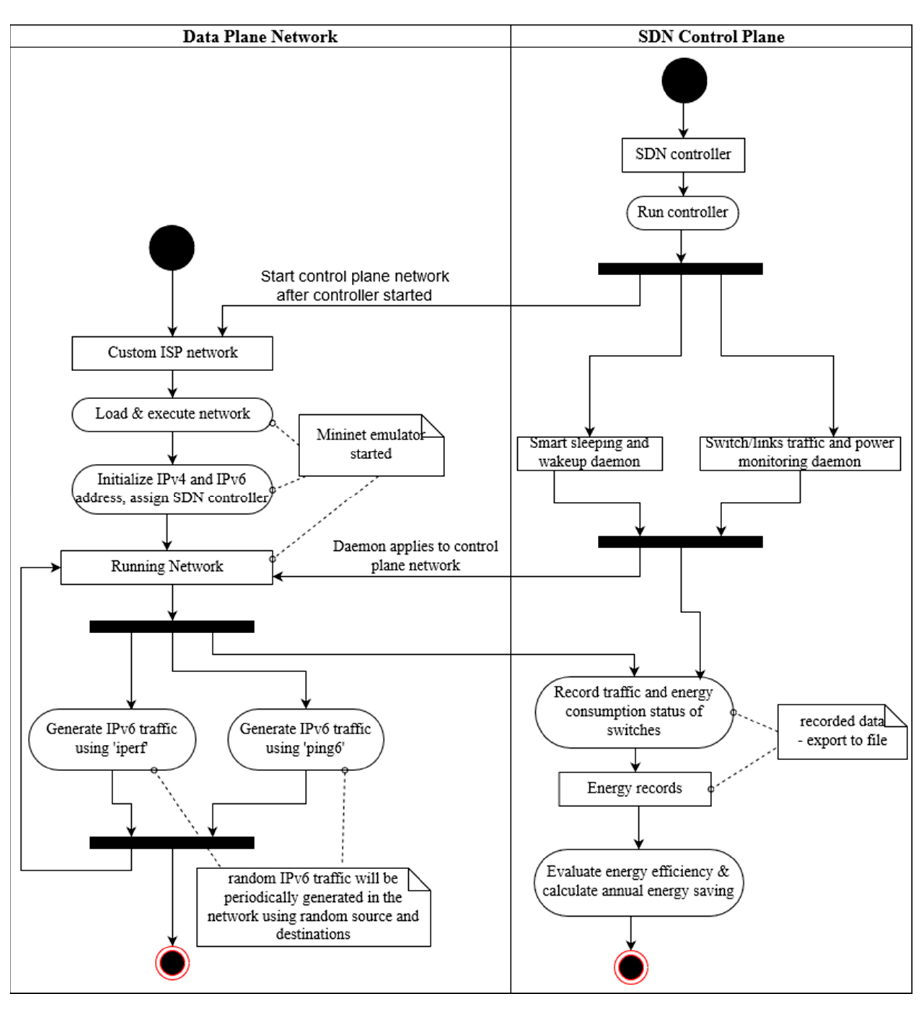
Figure 3. Activity diagram showing the steps at simulation environment. SDN, software defined networking. Algorithm 1. Pattern of Energy Consumption Recording of the SoDIP6 Network.